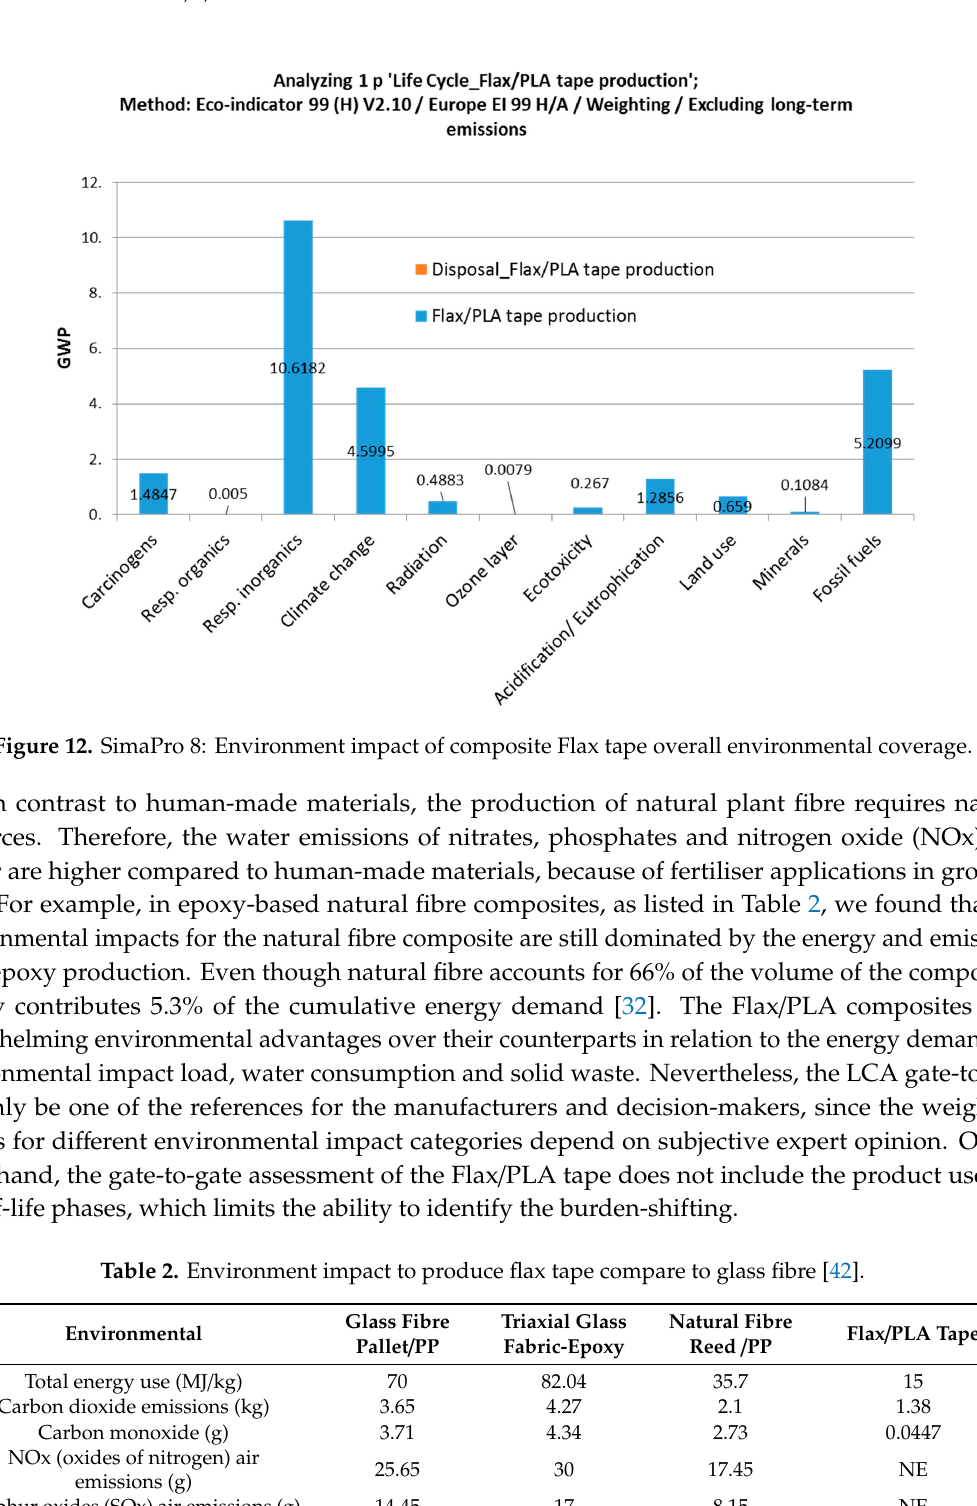
Figure 11. SimaPro 8 : Environment impact of triaxial glass fibre fabric overall environment coverage.